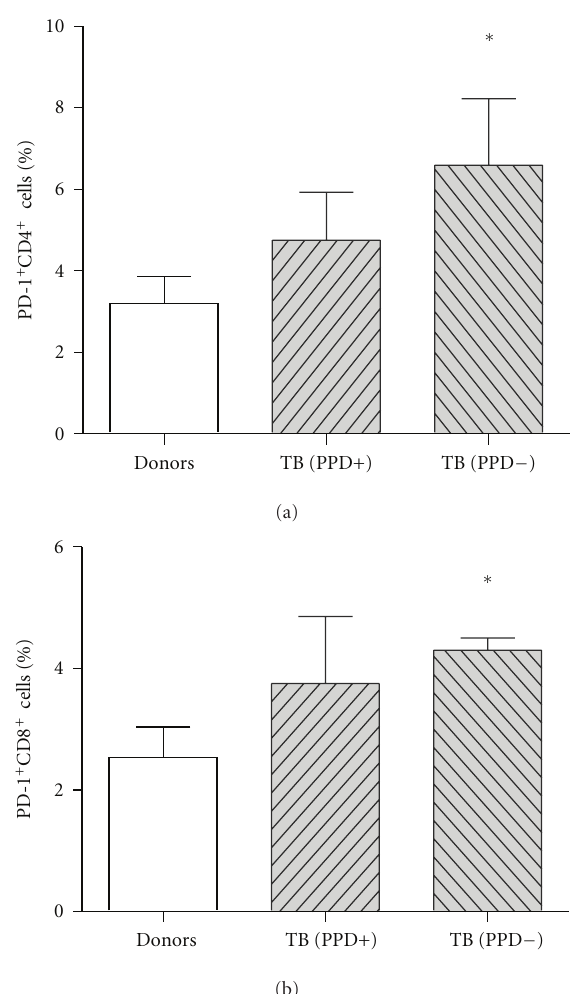
Figure 3: The number of freshly isolated PD-1 + CD4 + and PD- 1 + CD8 + cells in PPD-anergic TB patients was higher than that of healthy donors. The numbers of PD-1 + CD4 + (M ± S.E.) cells (a) and of PD-1 + CD8 + cells (b) were detected in the peripheral blood of healthy donors: PPD-reactive and PPD-anergic TB patients.